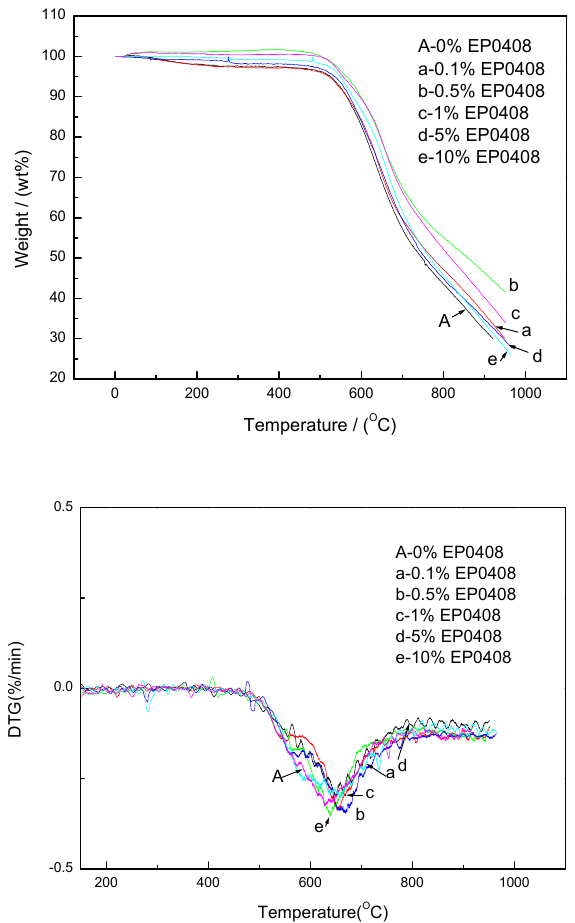
Figure 4. Thermogravimetric analysis (TGA) and Derivative Thermogravimetry (DTG) plots of the neat polymer and the polymers with different EP0408 contents under an air atmosphere.